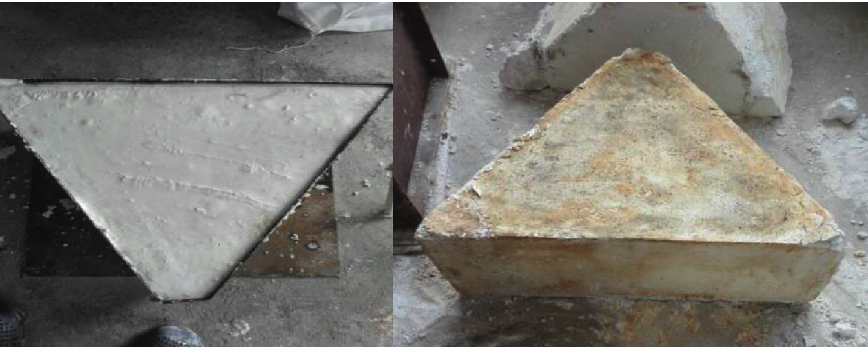
Figure 2: Dam body